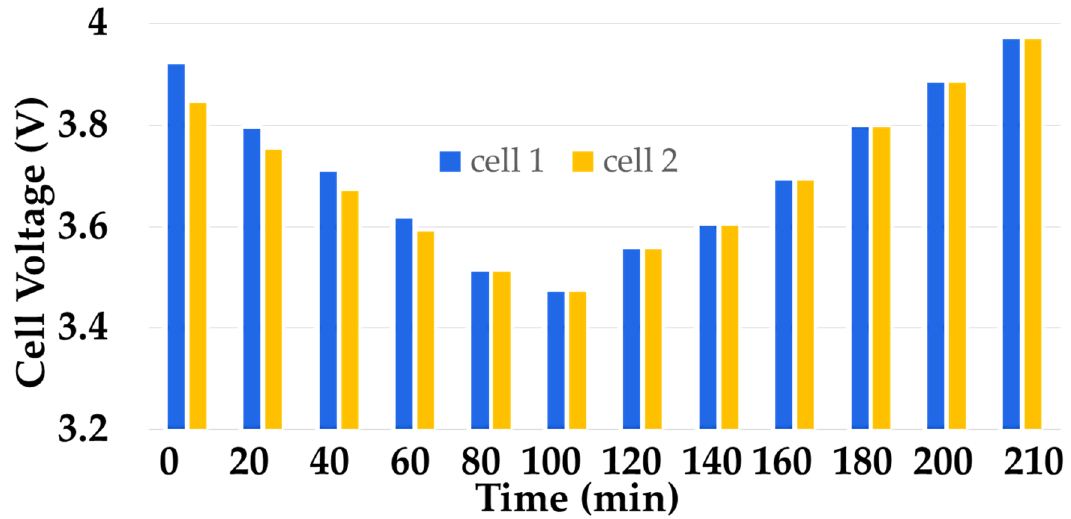
Figure 12. Experimental result: measured for two Li-ion cells balancing circuit test under discharging/charging time. ( I dis = I ch = 1 A).